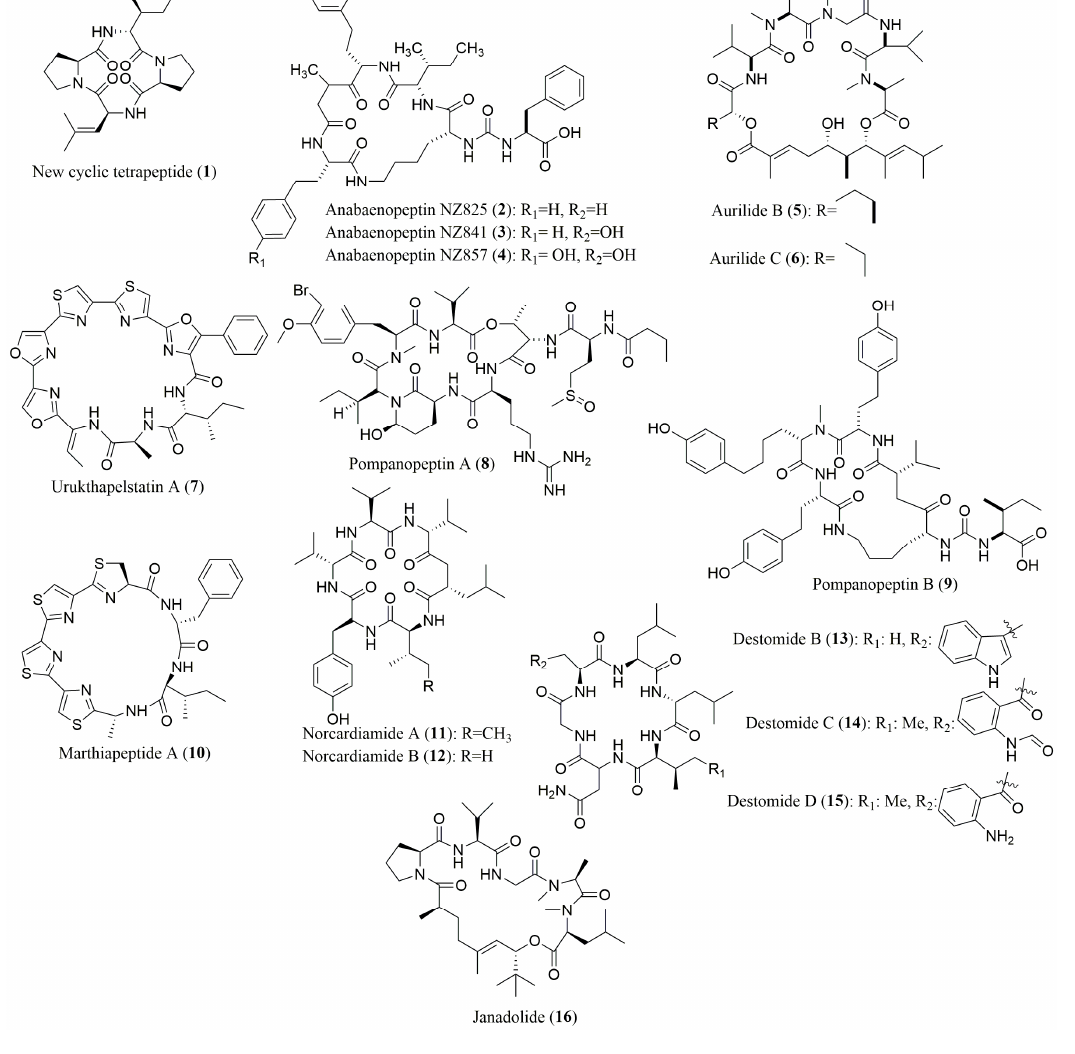
Figure 2. Structure of cyclic peptides 1 – 16 , isolated from marine cyanobacteria and other bacteria, whose stereochemistry determination of their amino acids was performed by Marfey’s method (compounds 1 – 4 ) and by a combination of both Marfey’s method and chiral HPLC (compounds 5 – 16 ).